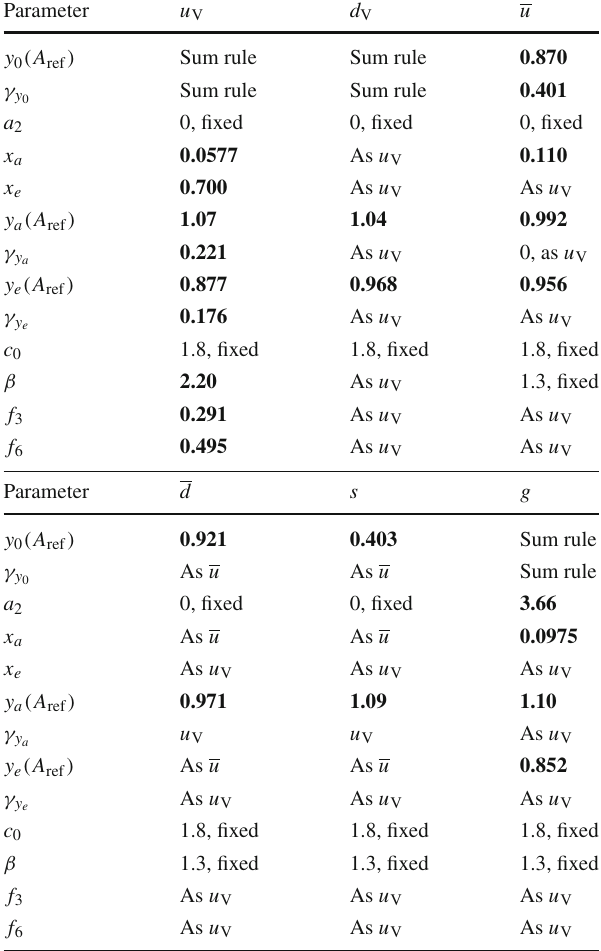
Table 1 Values of parameters that define the central EPPS21 nuclear = 1 . 69GeV 2 . The 24 parameters that were kept free in the PDFs at Q 2 0 fit are indicated in bold